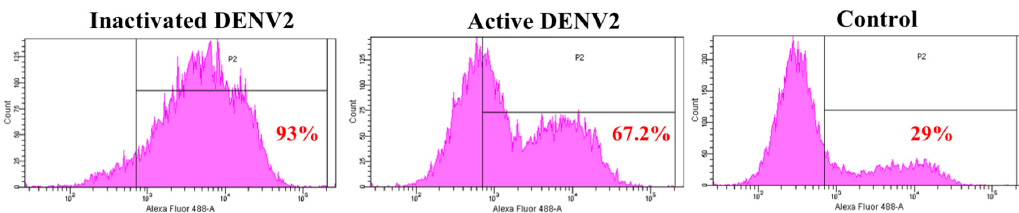
Figure 2. Detection of annexin II on the Vero cells. Vero cells were either exposed with inactivated DENV2 or MOI 2 of DENV2, or mock-exposed for 30 min and 37 ◦ C. Vero cells were fixed and stained with anti-annexin II, followed by Alexa Fluor ® 488-conjugated donkey anti-rabbit IgG. The Vero cells were analyzed using the BD FACS Canto II flow cytometer and BD FACSDiva analysis software. Percentage of annexin II positive cells in P1 region is in